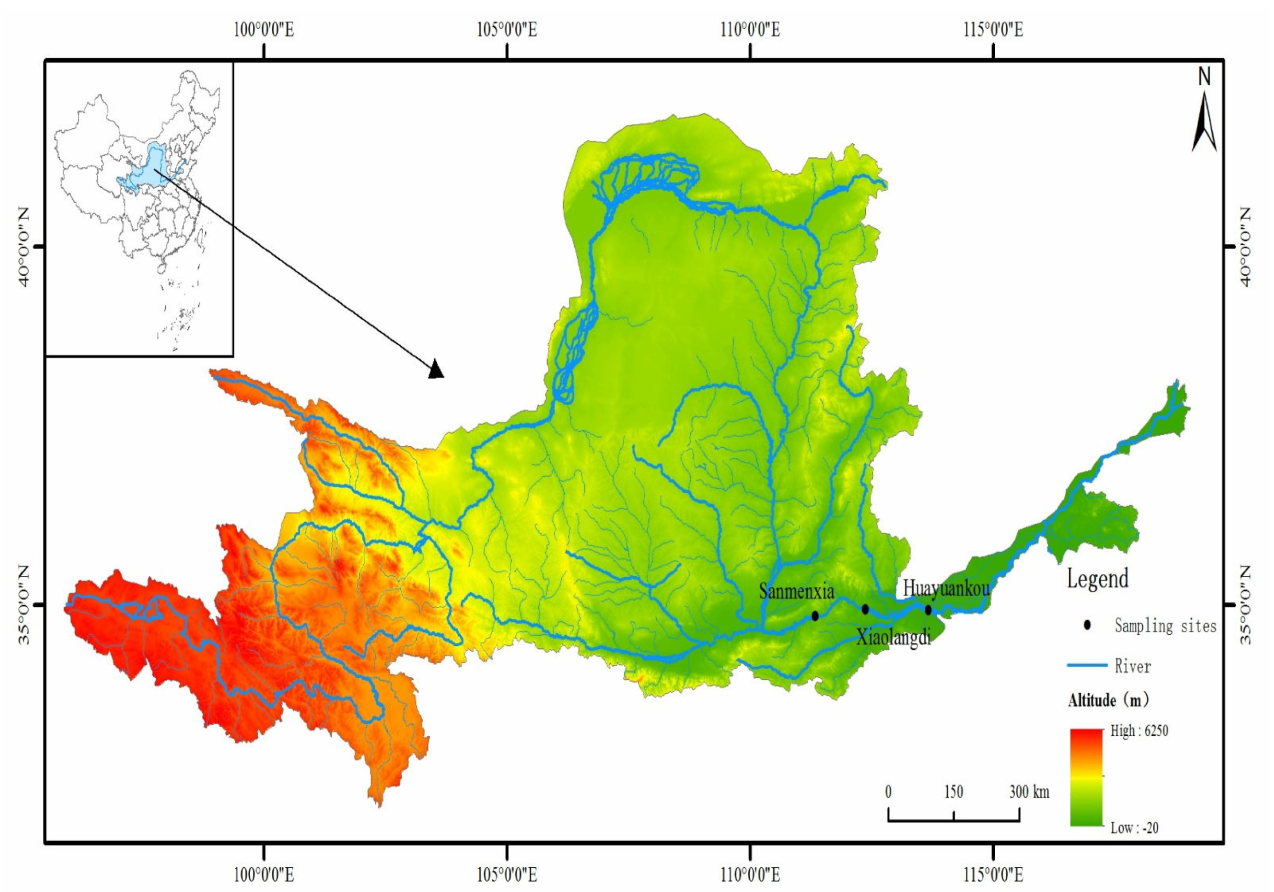
Figure 3. Water system of the Yellow River basin.